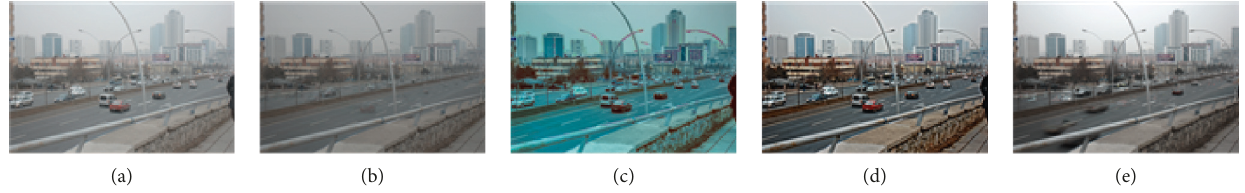
Figure 4: Comparison results on “FastCars” with (a) the proposed method; (b) Oh et al. [26]; (c) Hu et al. [18]; (d) Ma et al. [32]; (e) Photoshop cs6.